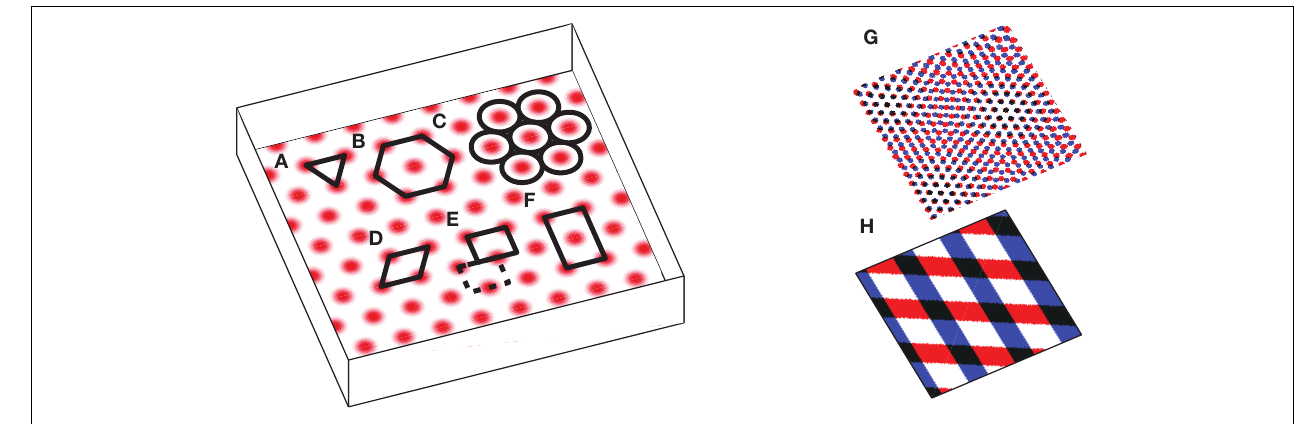
one field is used, it must be twisted so that walking off the bottom on the left brings the animal to the top on the right (the top edge is shifted by half its width, see dashed rectangle), while walking off the left or right sides wraps around normally.The grid can also be thought of as the overlap or interference between other spatial patterns, such as (G) smaller scale grids or (H) sinusoid-like gratings, not unlike a Fourier decomposition of the grid, and this produces the temporal interference models when generalized to the temporal domain. Note that in all figures spatial plots are shown in perspective to distinguish them from 2D plots of neural activities or synaptic